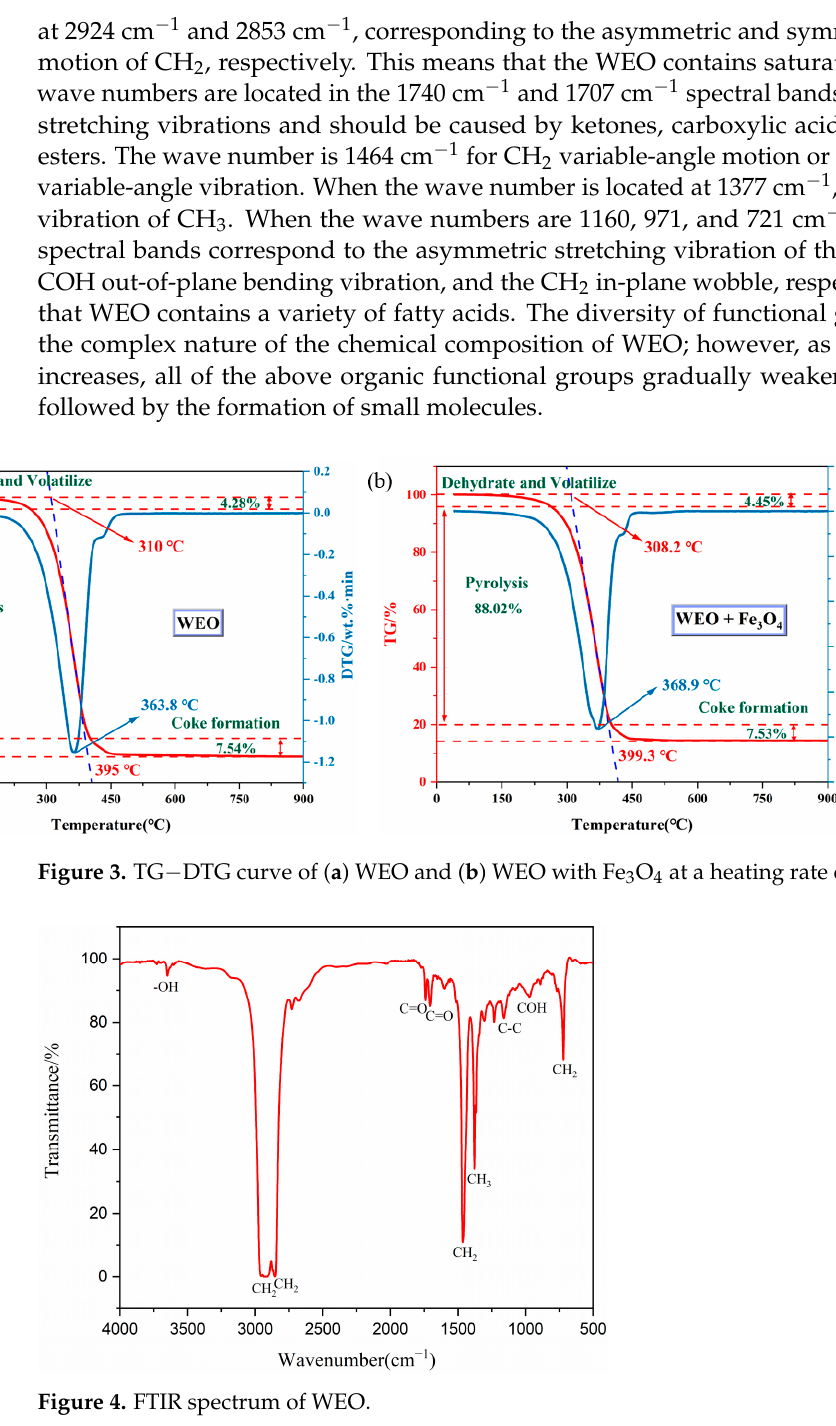
Figure 3. TG − DTG curve of ( a ) WEO and ( b ) WEO with Fe 3 O 4 at a heating rate of 10 °C /min.